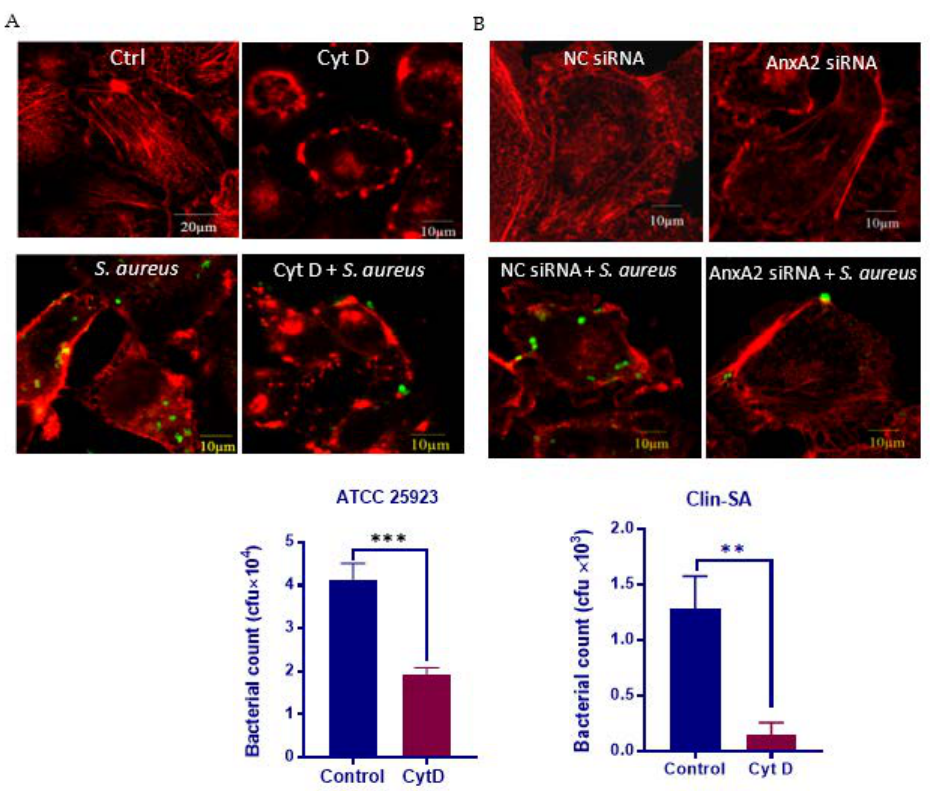
Figure 2. Engagement of AnxA2 in S. aureus -induced cytoskeleton reorganization. MAC-T cells were pre-treated with cytochalasin D (Cyt D) for 2 h ( A – C ) or AnxA2 siRNAfor 72 h ( D ), followed by infection with clinical isolate of S. aureus (Clin-SA, FITC-labeled) or S. aureus strain ATCC 25923 for 1 h. F-actin was visualized by TRITC-conjugated phalloidin ( A , D ). Representative confocal microscopy images of cells infected with Clin-SA are shown (Green: S. aureus ; Red: F-actin). Invasion of Clin-SA ( B ) as well as ATCC 25923 ( C ) was determined by gentamicin protection assay. The graph shows mean values ± s.d. of three replicates. Each assay was repeated at least three times. ** p < 0.01 and *** p <